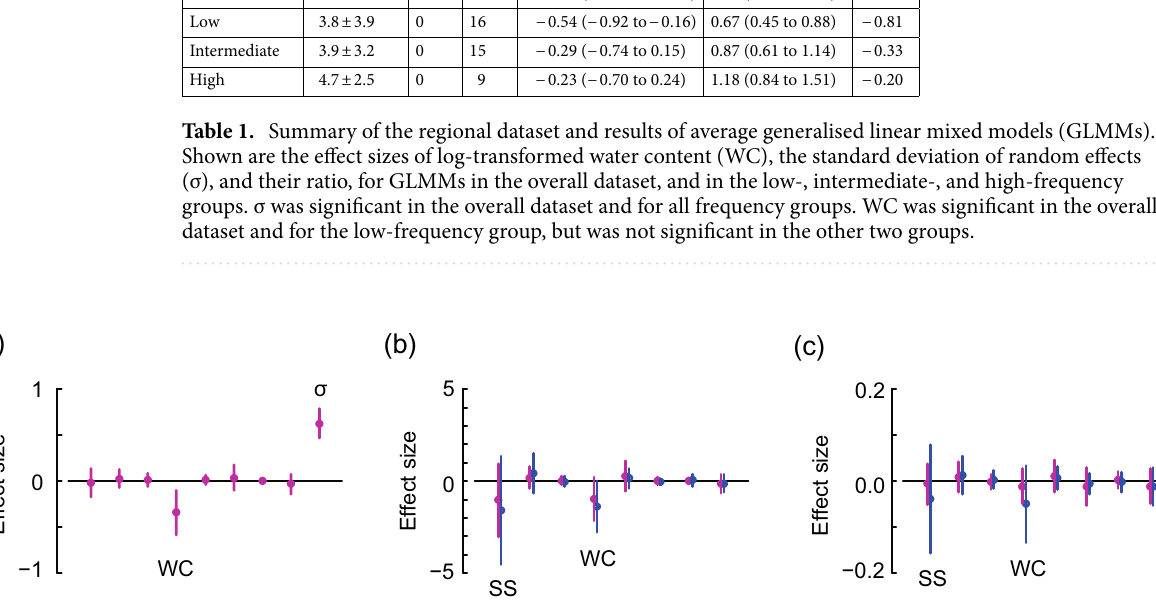
Figure 2. Results of averaged models using the regional dataset. Panels show ( a ) generalised linear mixed model results for the number of families observed, ( b ) generalised linear model results for Hill–Simpson diversity, and ( c ) Pielou evenness. The effect sizes of standardized sample size (SS), latitude, water depth, log- transformed water content (WC), log-transformed median sediment particle size, total organic carbon (TOC), interaction between TOC and the carbon/nitrogen molar ratio, and sediment temperature are shown from left to right in each panel. The standard deviation of estimated random effects (σ) is shown on the right side of ( a ). Circles and bars represent means and 95% confidence intervals, respectively. Magenta and blue indicate results from the overall data ( N = 65 for the number of families and Hill–Simpson diversity; N = 60 for Pielou evenness) and for reliable data from samples with at least 50 individuals ( N = 36 for both Hill–Simpson diversity and Pielou evenness),